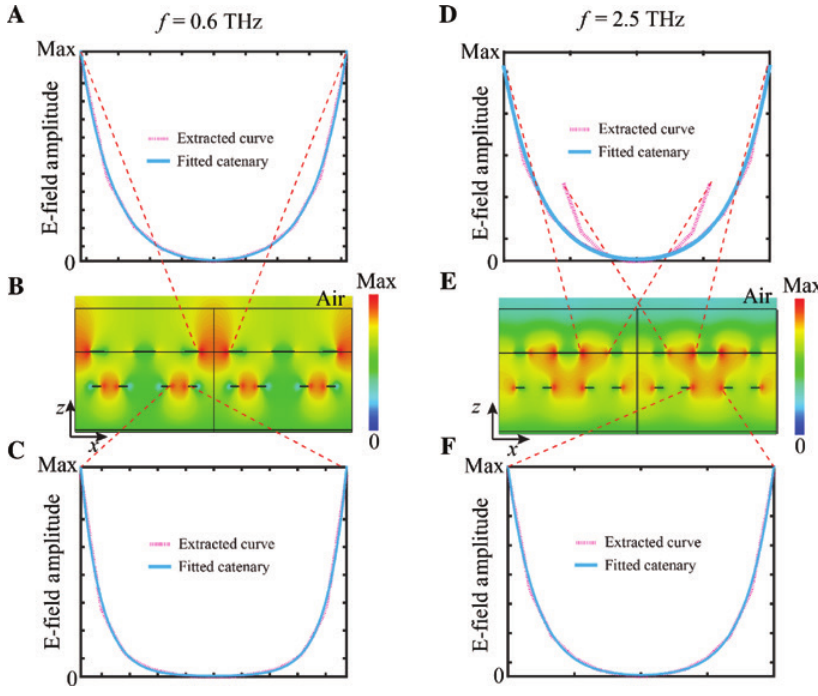
Figure 4: The analytical catenary field model of dual-metasurface. Extracted electric field amplitude (red dotted line) and fitting catenary curve (blue solid line) between two arms of the resonator and adjacent resonators for the dual metasurface at 0.6 THz (A and C) and 2.5 THz (D and F), respectively. The slightly discrepancy is because the extracted field is the superposition of the catenary field (evanescent field) and incident field. (B and E) Electric field distribution in the x - z plane at two resonant